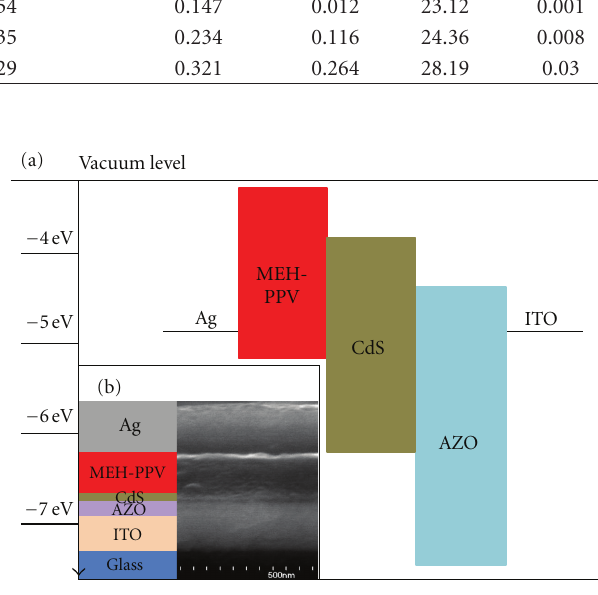
Figure 3: (a) An energy band diagram. (b) The AZO/CdS/MEH- PPV device and its cross-section SEM image.